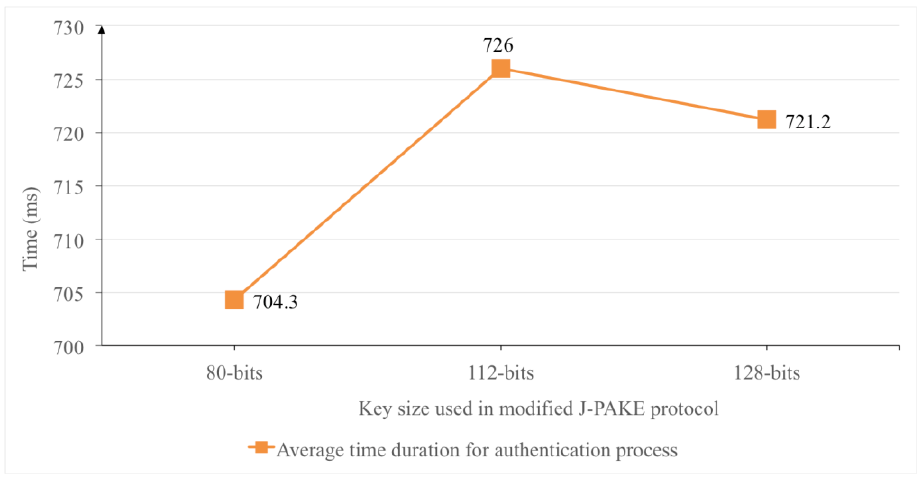
Figure 16. The average time duration of the authentication process over three different key sizes in the modified J-PAKE protocol.